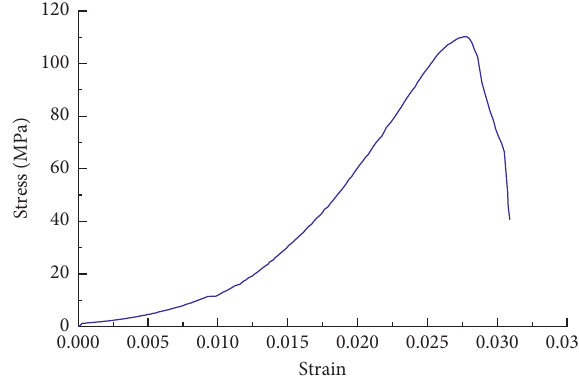
Figure 9: Stress-strain curve of limestone under static